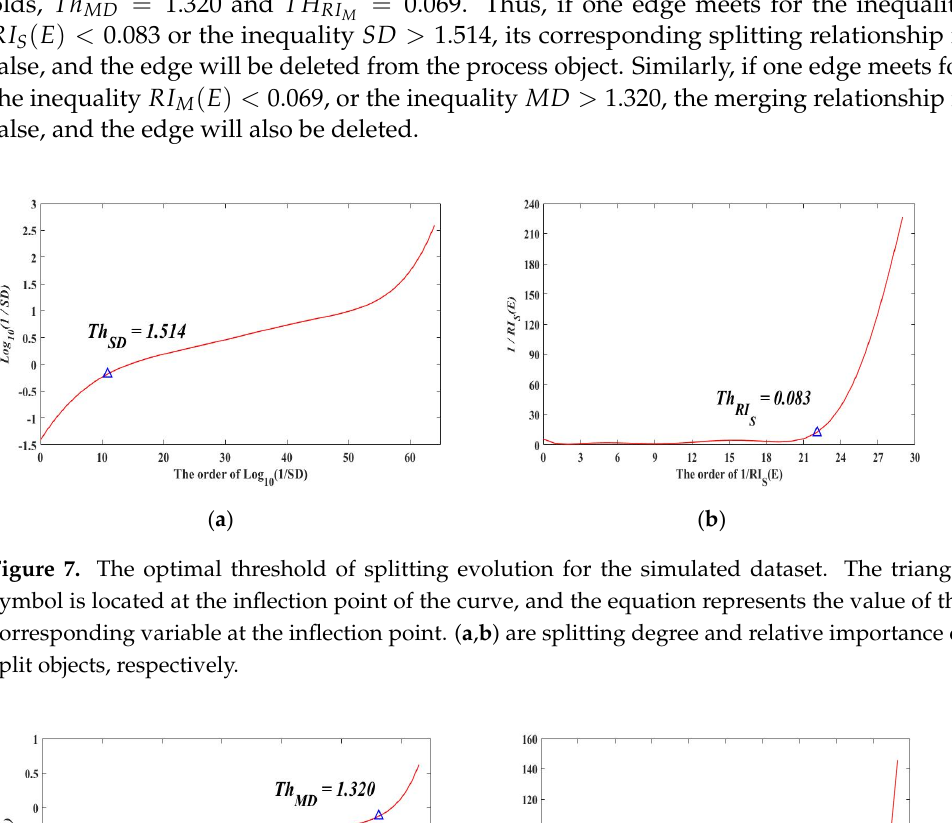
Figure 6. The calculation of linking thresholds. The triangle symbol is located at the inflection point of the curve, and the equation represents the value of the corresponding variable at the in- flection point.